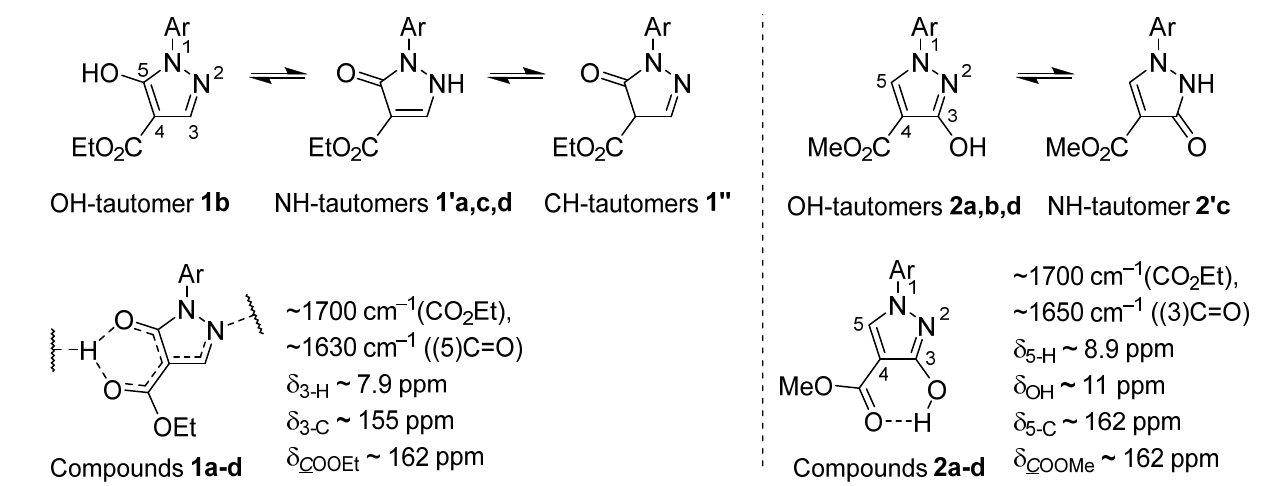
Figure 4. The structure and tautomerism of pyrazoles 1a – d and 2a – d . Table 4. Pf DHODH enzyme inhibition data for compounds 1a–d , 2a–d , and 3c .